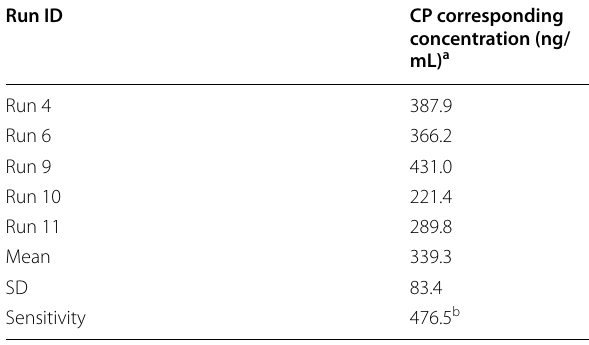
t 0.05, Z (one side) +